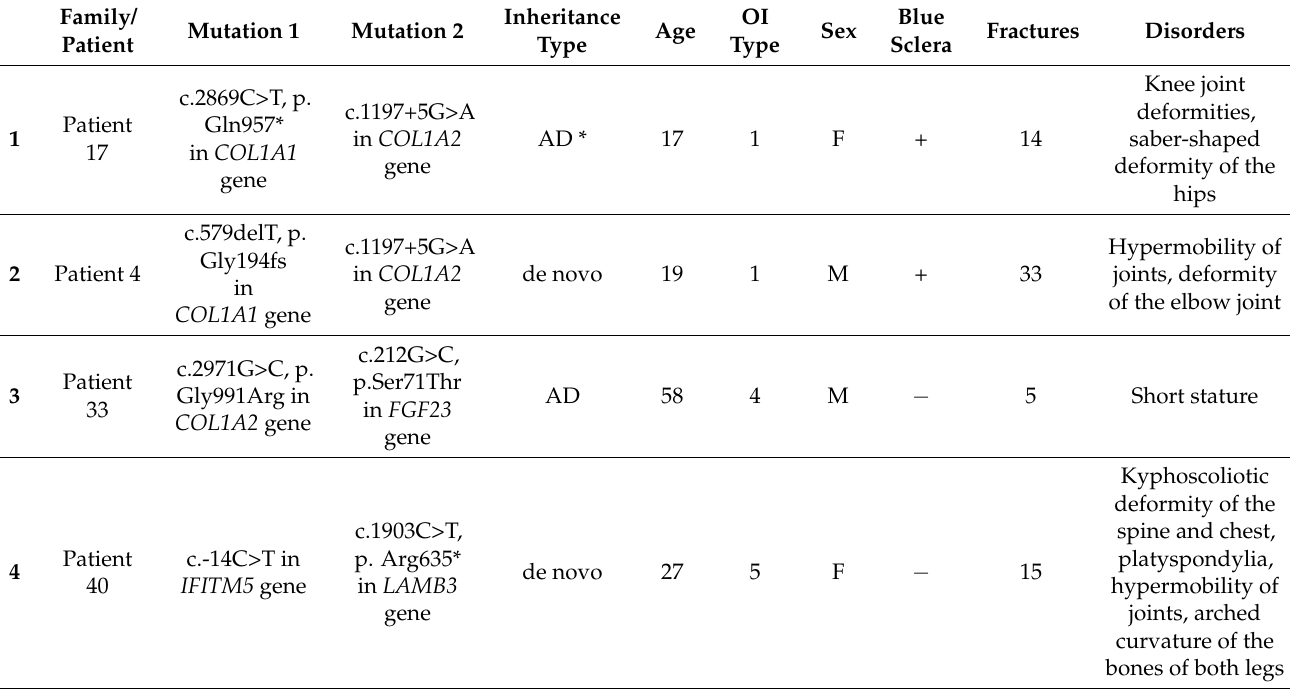
Table 4. Clinical characteristics of patients with combined